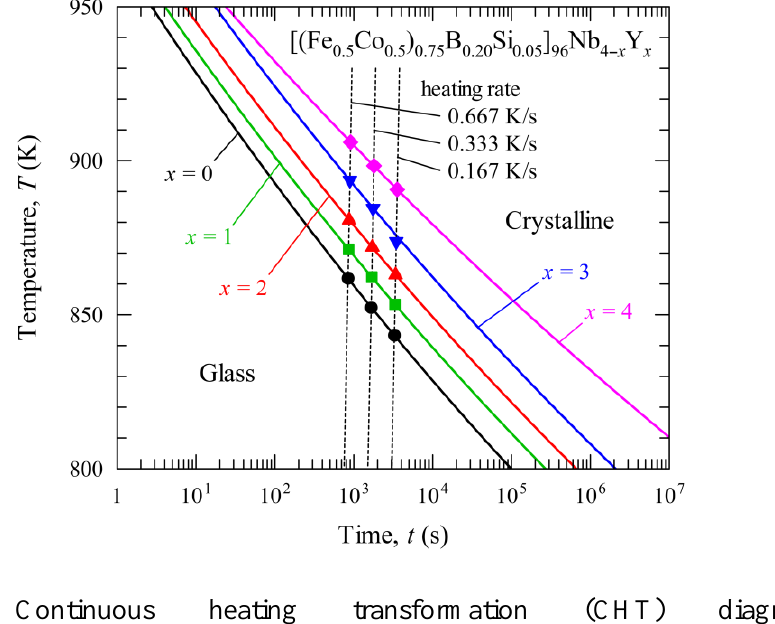
Figure 5. Continuous heating transformation (CHT) diagram of [(Fe 0.5 Co 0.5 ) 0.75 B 0.20 Si 0.05 ] 96 Nb 4− x Y x alloys. The symbols represent the experimental values of the onset temperature of crystallization ( T x ) obtained by the differential scanning calorimetry (DSC) in the continuous